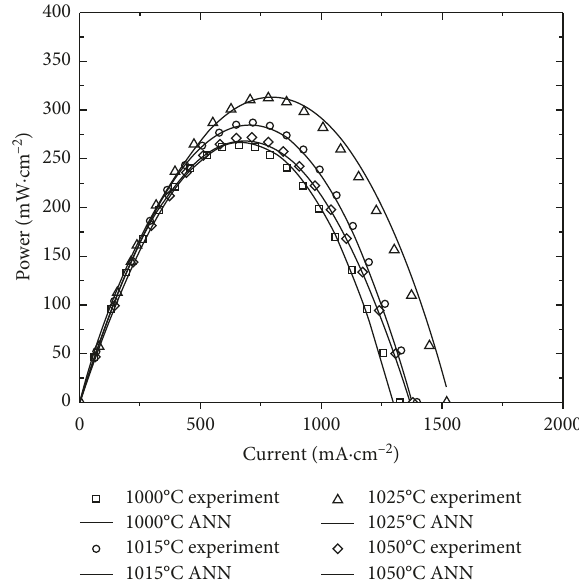
Figure 10: The power performance of the cell at different sintering